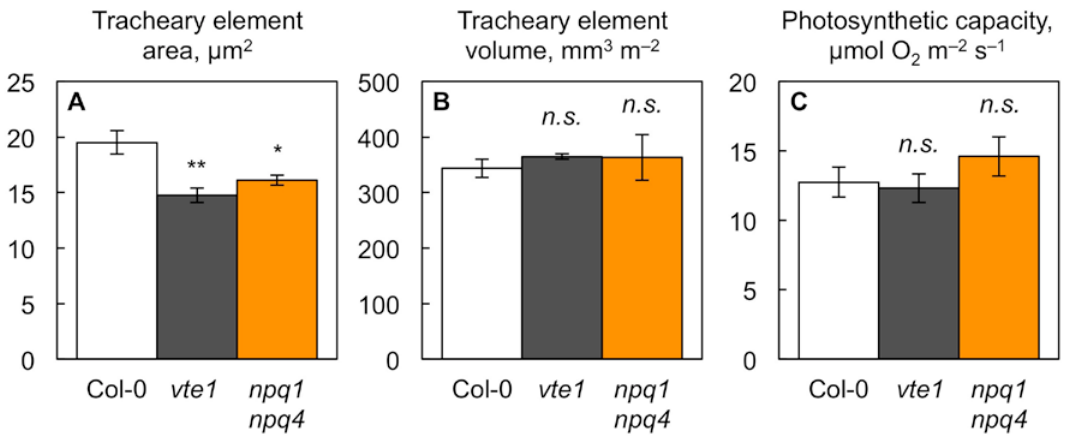
Figure 3. ( A ) Individual tracheary element cross-sectional area, ( B ) total tracheary element volume per leaf area, and ( C ) photosynthetic capacity (light-saturated and CO 2 -saturated rate of oxygen evolution determined at 25 ◦ C) from leaves of wild-type Col-0 (open columns) and the vte1 (dark gray columns) and npq1 npq4 (orange columns) mutants of Arabidopsis thaliana grown at 35 ◦ C. Mean values ± standard errors for ( A , B ) and ± standard deviations for ( C ) ( n = 3 or 4). Significant differences (Student’s t -test) between Col-0 and the mutants are indicated by asterisks; * = p < 0.05, ** = p < 0.01, n.s. = not significantly different. Table 2. Number of water-transporting tracheary elements and sugar-exporting sieve elements (per minor vein and also normalized for vein density; from Figure 2A) in the leaves of wild-type Col-0 and the vte1 and npq1 npq4 mutants of Arabidopsis thaliana grown at 35 ◦ C. Vascular Features